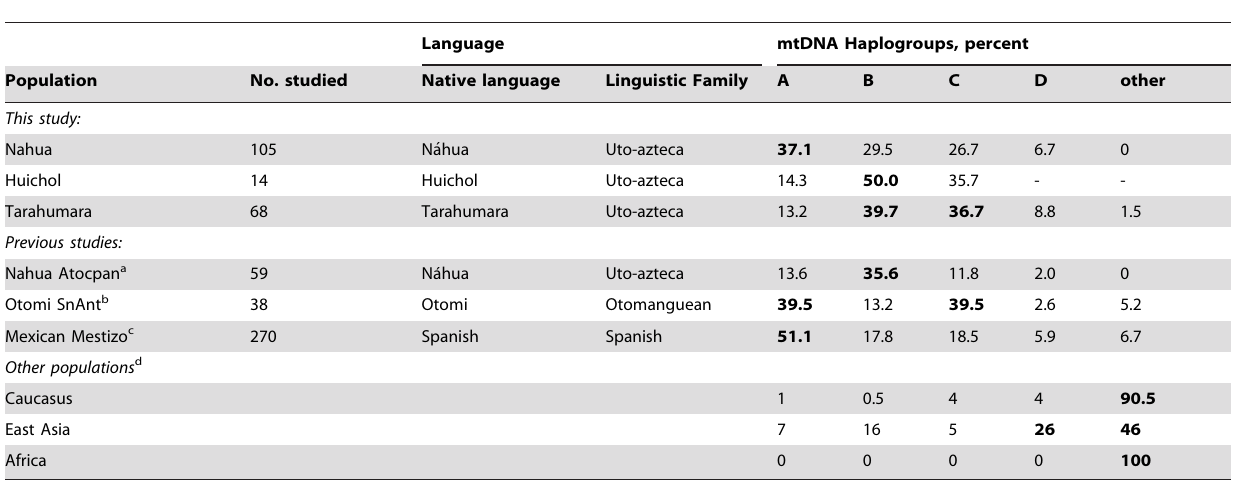
Table 1. Native language and frequency of mtDNA haplogroups in the Mexican Indigenous populations of this study, contrasted with previous studies in Mexican and other